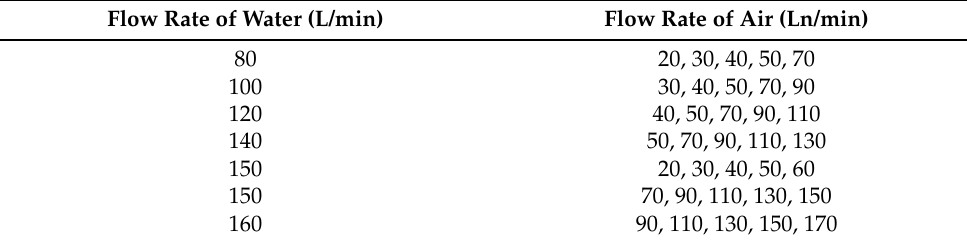
Table A1. Gas and liquid flow rates used in the study of the connection between the gas core and the upstream flow. In the table, Ln/min stands for normal liters per minute, defined as the volumetric flow rate of gas calculated from measurements of mass flow rate considering the density of air at 0 °C and 1 atm (Section